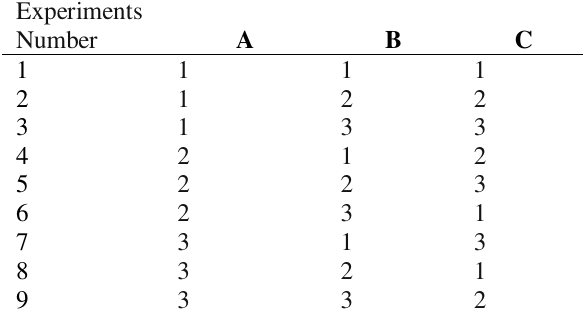
Taguchi L9 “Orthogonal Array”